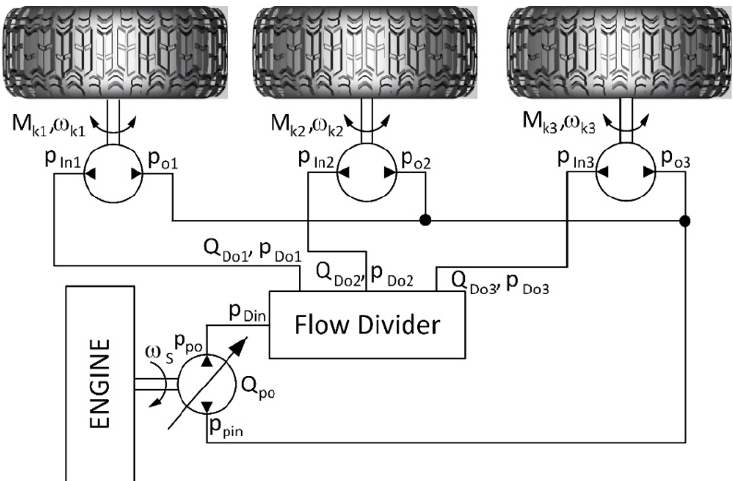
Figure 8. Concept of a hydrostatic drivetrain model for half-vehicle body model